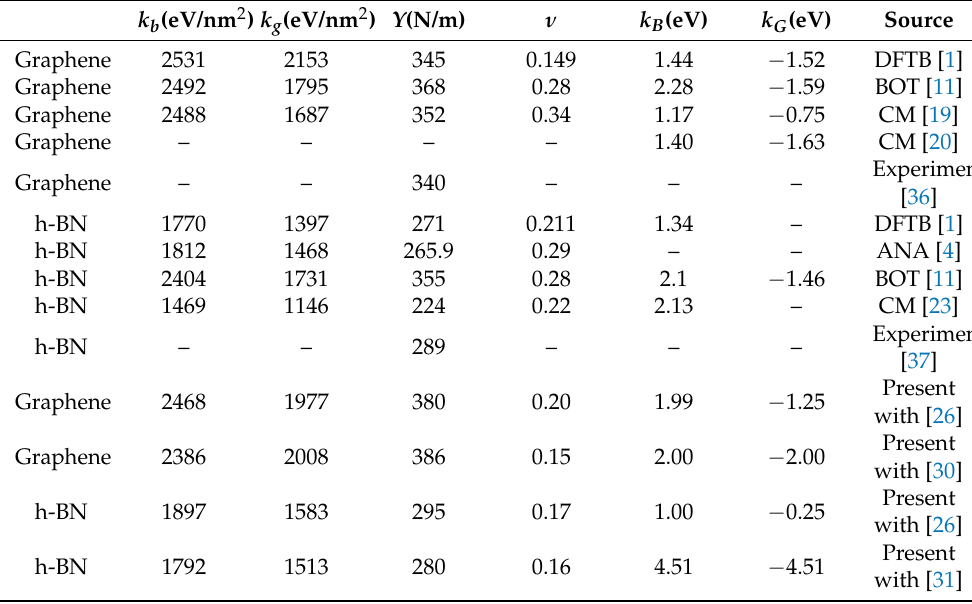
Table 2. The mechanical parameters of h-BN and